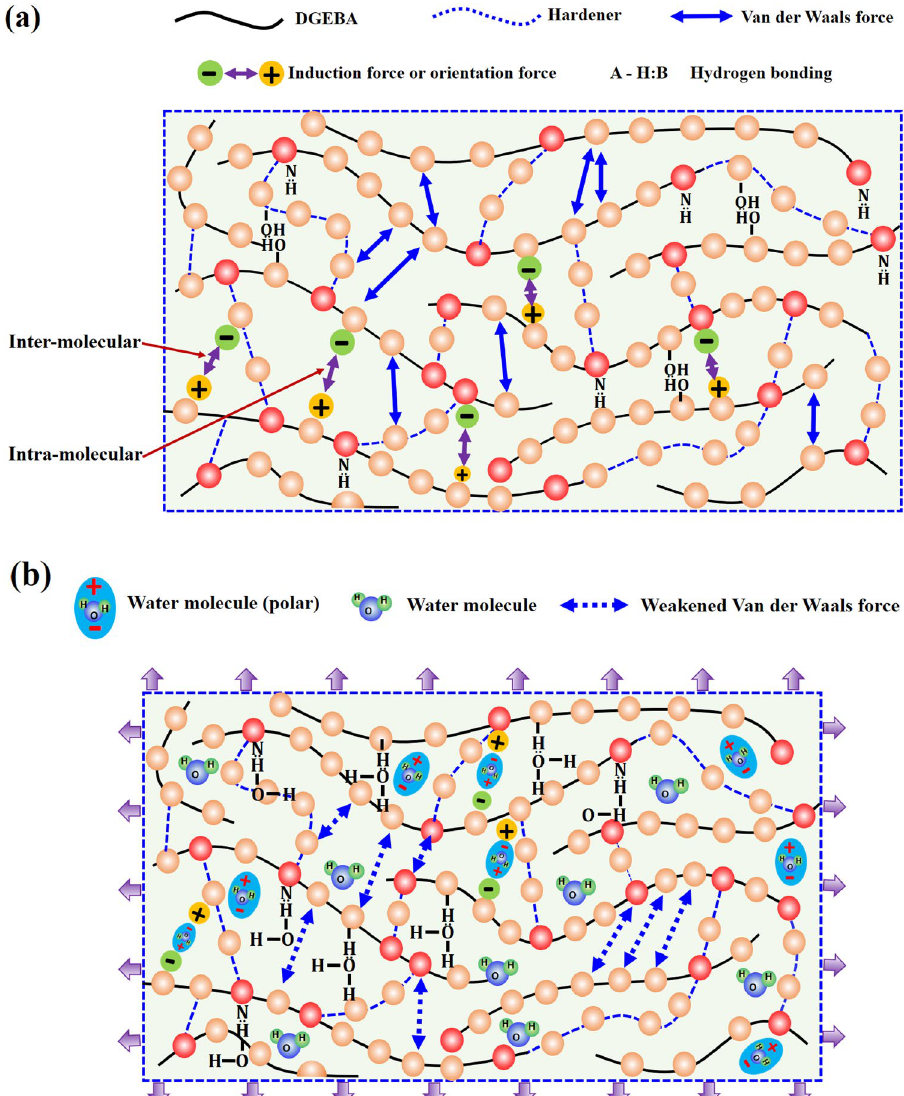
Figure 11. Schematic diagram of the ( a ) Van der Waals force, induction force or orientation force, and hydrogen bonding of epoxy molecules before absorbing the moisture content and ( b ) interaction between the moisture content and epoxy, weakened Van der Waals force, and disruption of hydrogen bonding of epoxy molecules after absorbing